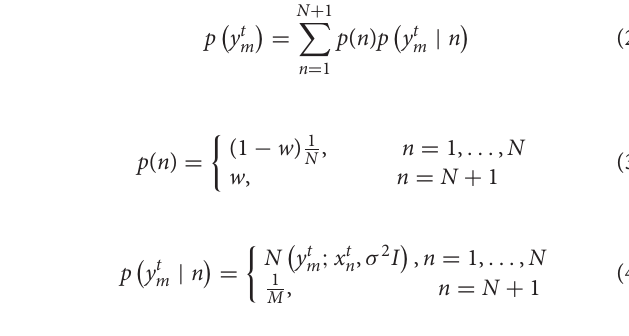
covariance σ I , and the probability of point cloud belonging to each Gaussian distribution is the same: 1